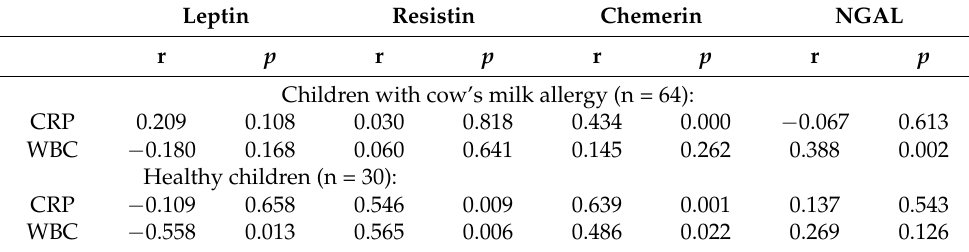
Table 7. Spearman correlations between concentration of adipokines and routinely determined parameters (CRP, WBC) in patients with cow’s milk allergy and in healthy children. Leptin Resistin Chemerin NGAL r p r p r p r p Children with cow’s milk allergy (n = 64): CRP 0.209 0.108 0.030 0.818 0.434 0.000 − 0.067 0.613 WBC − 0.180 0.168 0.060 0.641 0.145 0.262 0.388 0.002 Healthy children (n = 30): CRP − 0.109 0.658 0.546 0.009 0.639 0.001 0.137 0.543 WBC − 0.558 0.013 0.565 0.006 0.486 0.022 0.269